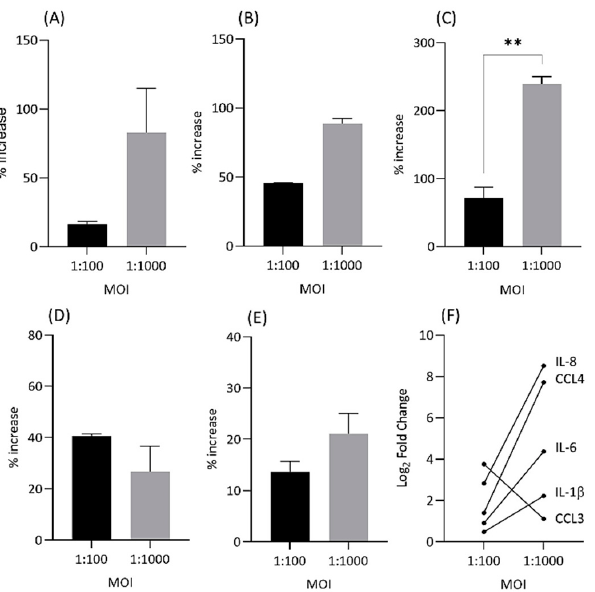
Figure 6. Percentage increase in protein expression (ng/mL) for IL-1 β ( A ), IL-6 ( B ), IL-8 ( C ), CCL3 ( D ) and CCL4 ( E ) at 24 h and MOIs = 1:100 and 1:1000 for infected vs. control NP cells. Changes in gene expression levels between MOIs for cytokines and chemokines by qPCR ( F ). Cell lysates from donor MH6352 cells only were assayed in duplicate for IL-1 β , IL-6, IL-8 and CCL3, while ML7362 was used for CCL4. ** p < 0.01.